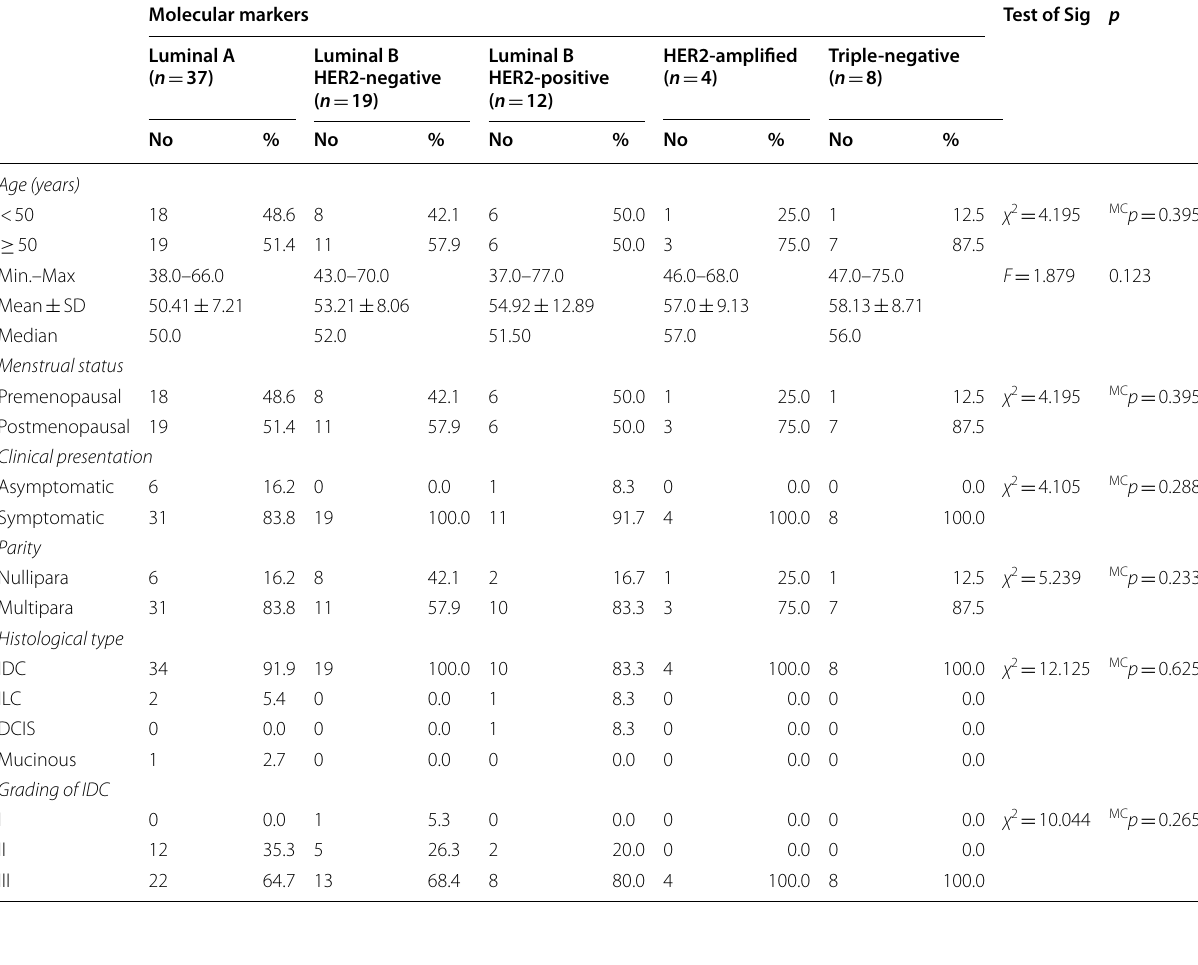
Table 3 MRI features correlation with molecular markers Molecular markers Test of Sig p